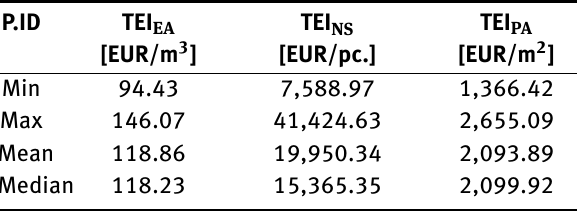
Table 6: Determination of the general values of TEI.